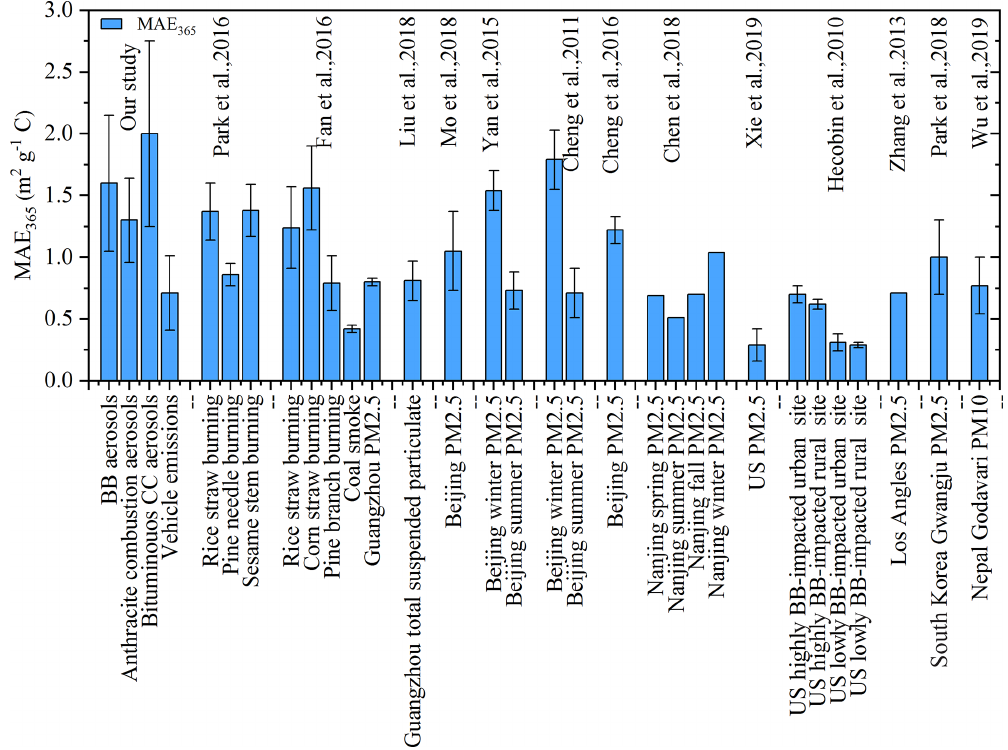
Figure 1. Comparison of MAE 365 in the WSOC fraction of source emission aerosols with the other studies. The references were listed as follows: Liu et al., 2018; Mo et al., 2018; Yan et al., 2015; Cheng et al., 2011; Cheng et al., 2016; Xie et al., 2019; Hecobian et al., 2010; Zhang et al., 2013; Park et al., 2018; Wu et al., 2019; Fan et al., 2016; Park and Yu, 2016; Chen et al.,